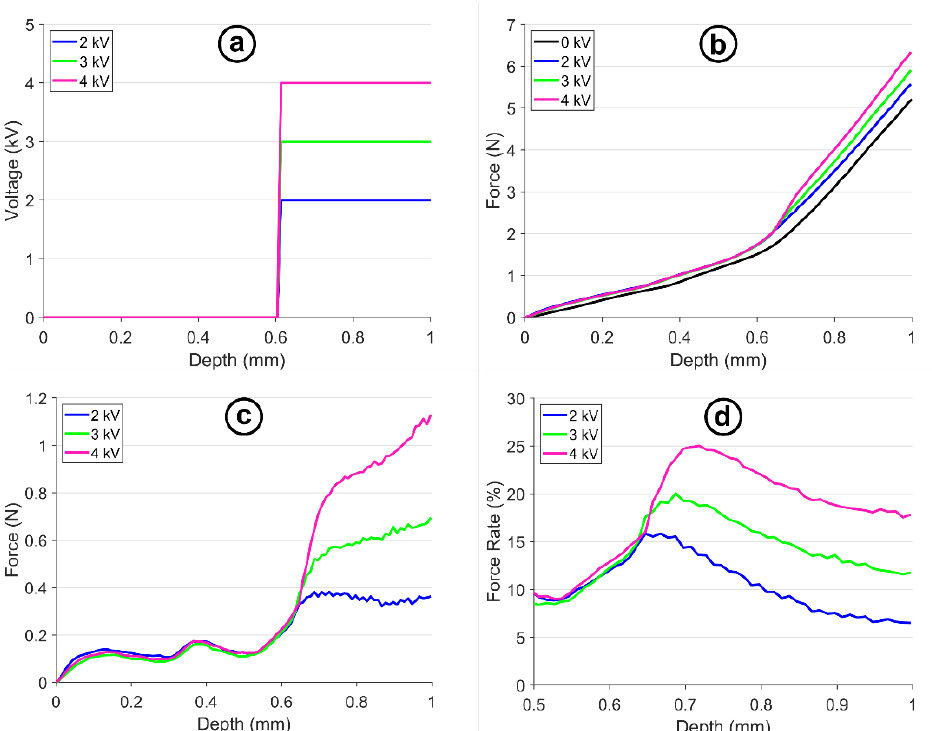
Figure 10. Results of the haptic step response testing: ( a ) programmed voltage step response with respect to indentation depth; ( b ) force–depth curve for 2, 3, and 4 kV pulses; ( c ) isolated force due to the ER effect; ( d ) force rate with respect to indentation depth focused on the effect of the step excitation.